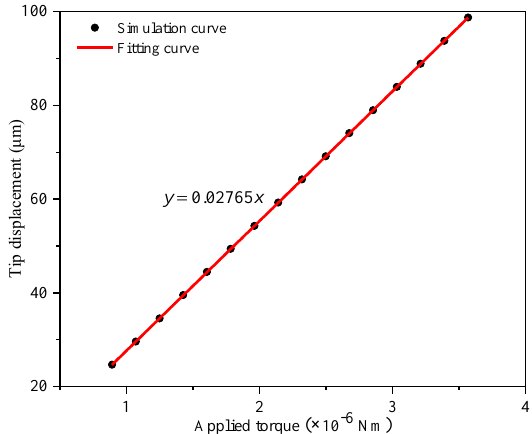
Figure 13. Tip displacement of the microgripper versus the applied torque on the moving elec- trode .